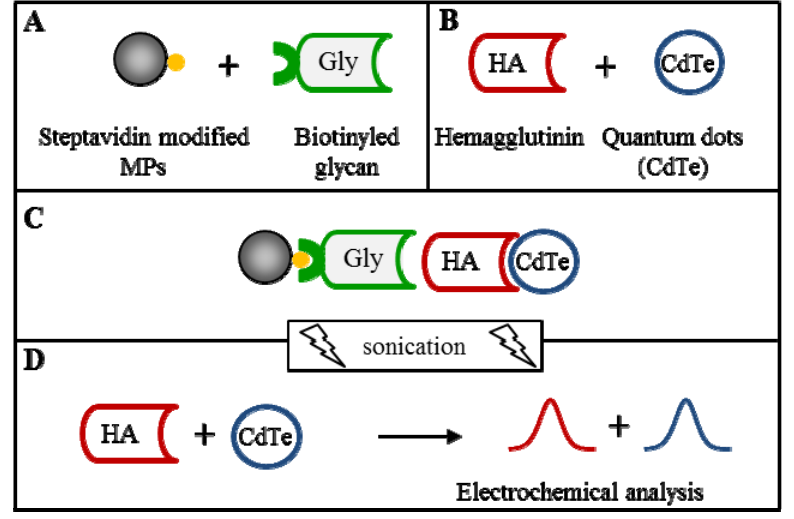
Figure 3. Scheme of isolation ( A + B + C ) and electrochemical detection ( D ) of vaccine hemagglutinin (vaxi HA) labeled with CdTe quantum dots (QDs); ( A ) Biotinyled glycan binding on streptavidin modified paramagnetic particles (MPs) based on biotin-streptavidin affinity, ( B ) HA labelling by CdTe, ( C ) magnetic isolation of HA-CdTe complex (based on glycan-HA affinity), followed by sonication and ( D ) electrochemical detection of HA and QDs parts. HA was detected by differential pulse voltammetry (DPV) connected with adsorptive transfer technique (AdT DPV) Brdicka reaction. QDs (Cd respectively) were detected by DPASV. Other experimental conditions see in Figure